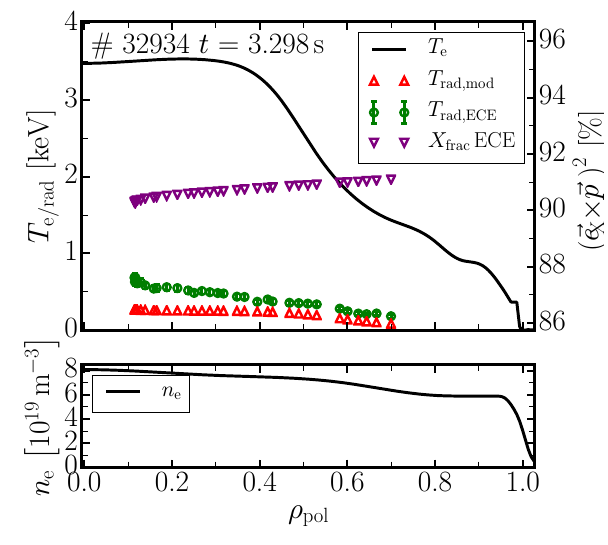
Figure 7. # 32934 at t = 3 . 298s: T e (top) and n e (bottom) profiles versus normalized poloidal radius (black lines). Radia- tion temperatures T rad , ECE (measured, green circles) is compared to T rad , mod (modelled with ECFM, red triangles), with the polar- (cid:0) (cid:1) 2 (cid:126) e X · (cid:126) p izing e ffi ciency of 91% shown as purple